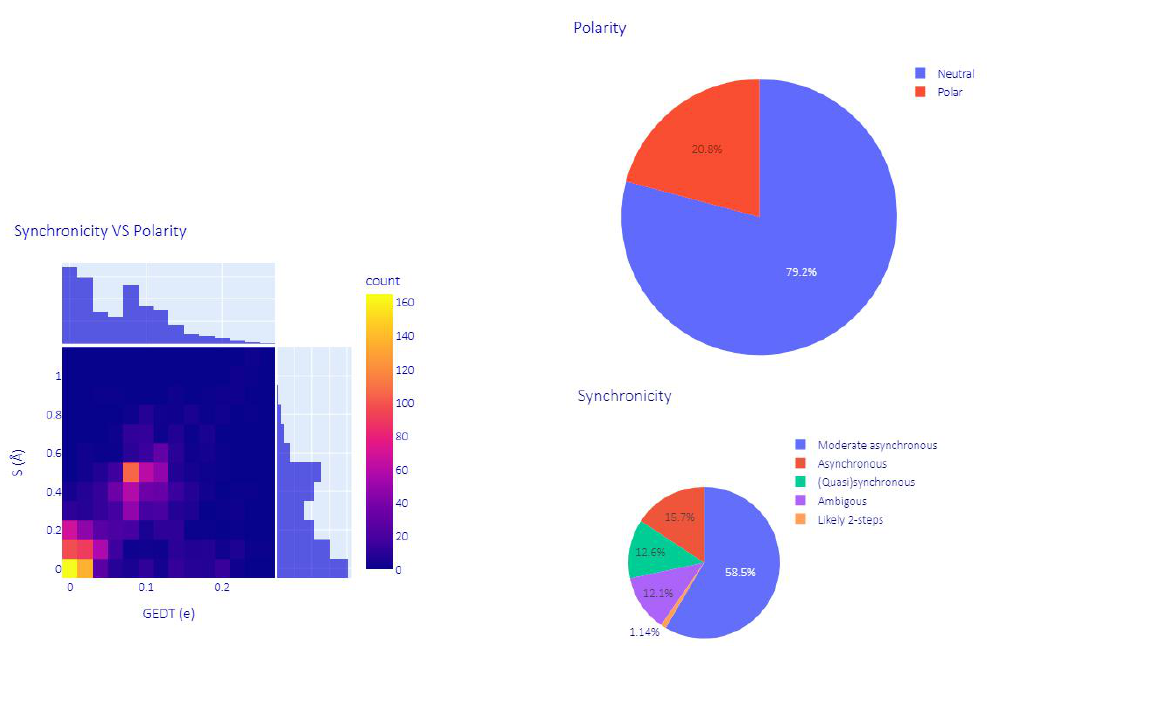
Figure 1. Overview of the dataset: synchronicity and polarity of the